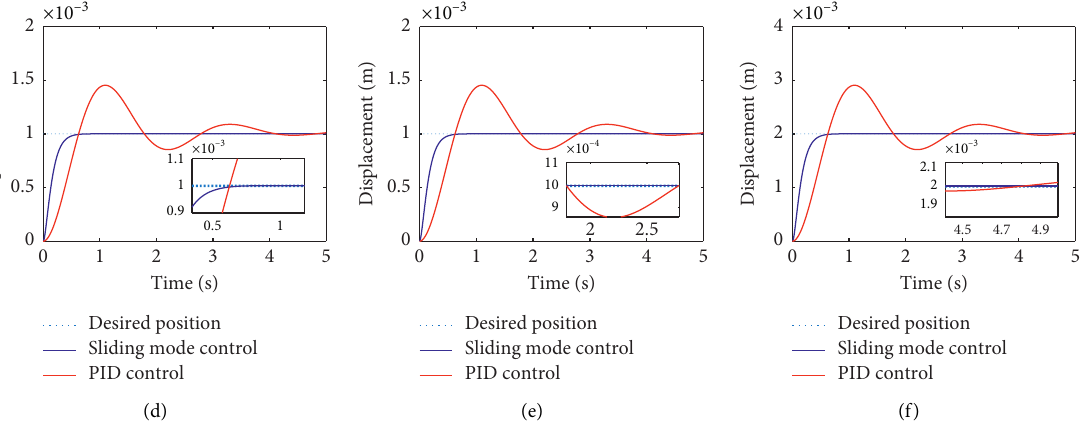
Figure 6: Large displacement (millimeter level) positioning test.